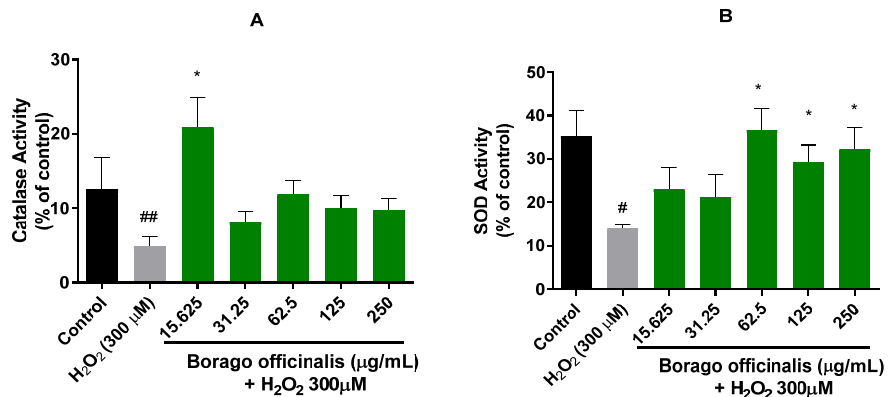
Figure 3. Neuro-2a endogenous antioxidant enzymes exerted by Borago officinalis flower extract treatments (15.62-250 µg/mL). ( A ) Catalase activity. ( B ) Superoxide dismutase activity. Note: * p < 0.05 versus H 2 O 2 ; # p < 0.05 versus control; ## p < 0.01 versus control.